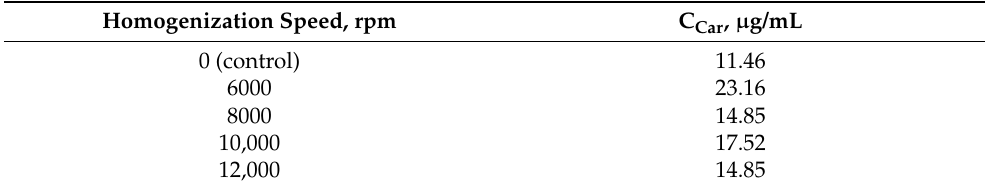
Table 2. Influence of the rate of homogenization on the yield of carotenoids in the extracts. Homogenization Speed, rpm